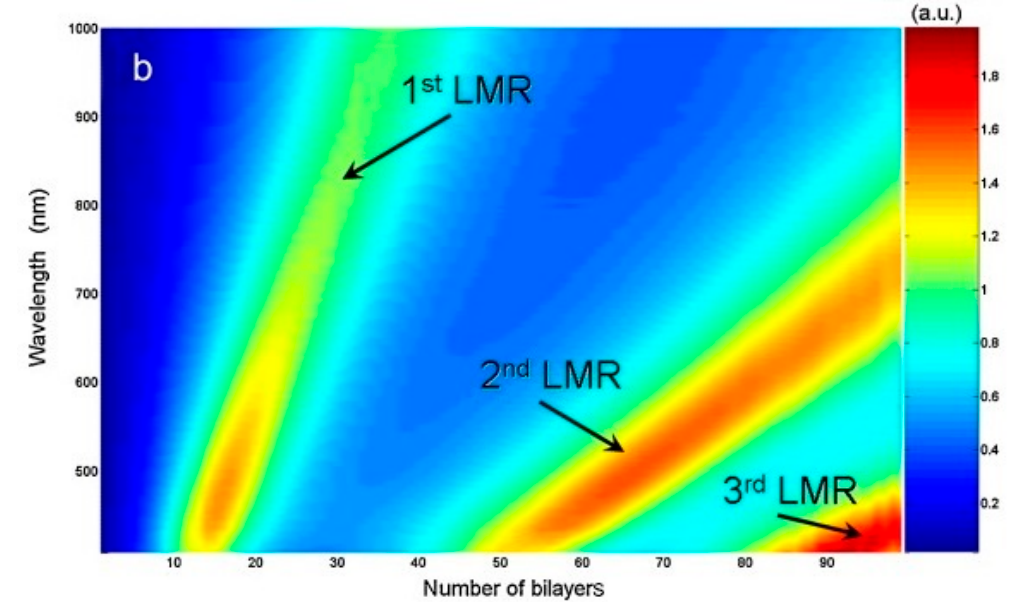
Figure 11. Transmittance spectra of a 200 µ m CRMOF as polyallylamine hydrochloride (PAH) and polyacrylic acid (PAA) bilayers are being deposited on it. Several absorption bands can be observed, corresponding to LMR. Reprinted from [55] with permission from Elsevier.